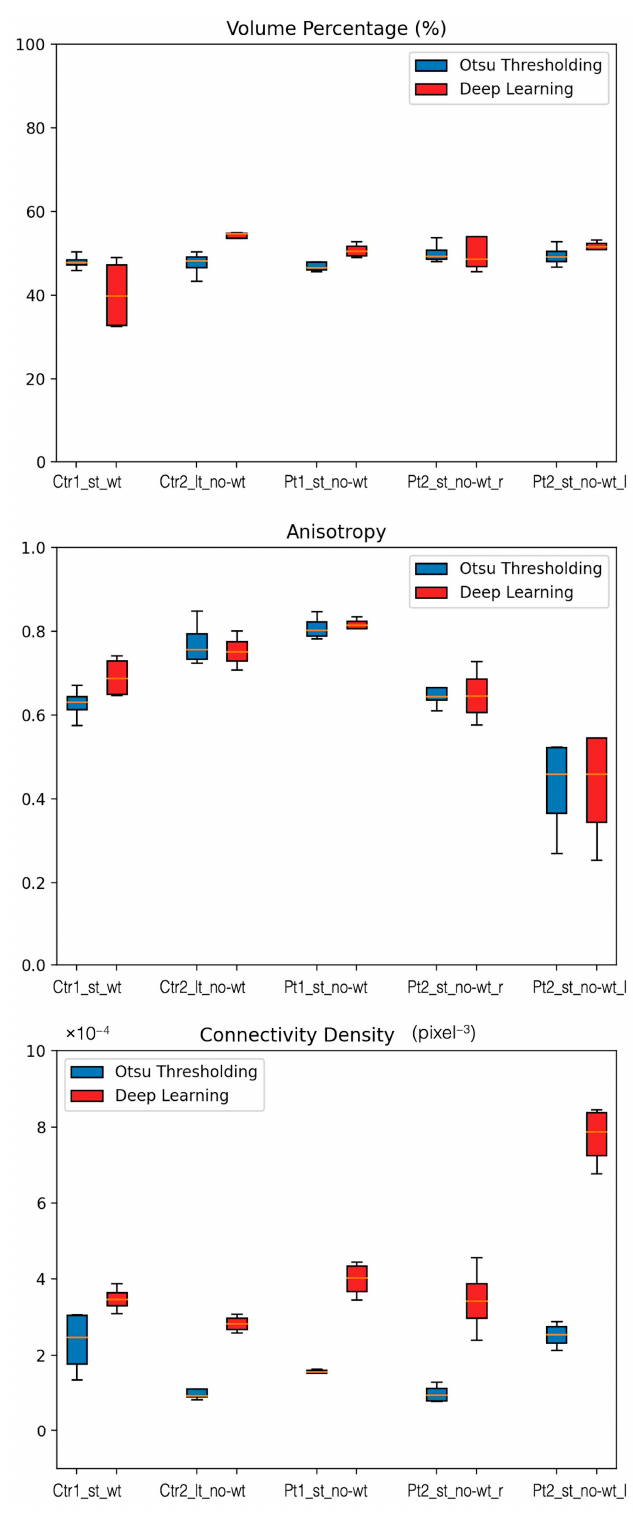
Figure 5. Box plots of volume percentage, degree of anisotropy and connectivity density calculated on each volume segmented with deep learning semantic method (red) and Otsu thresholding (blue). For deep learning, both longitudinal and transversal fibers were considered together for comparison.